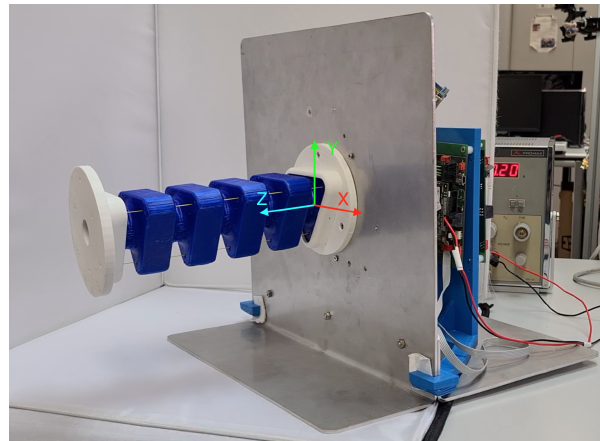
Figure 1. Soft robotic arm